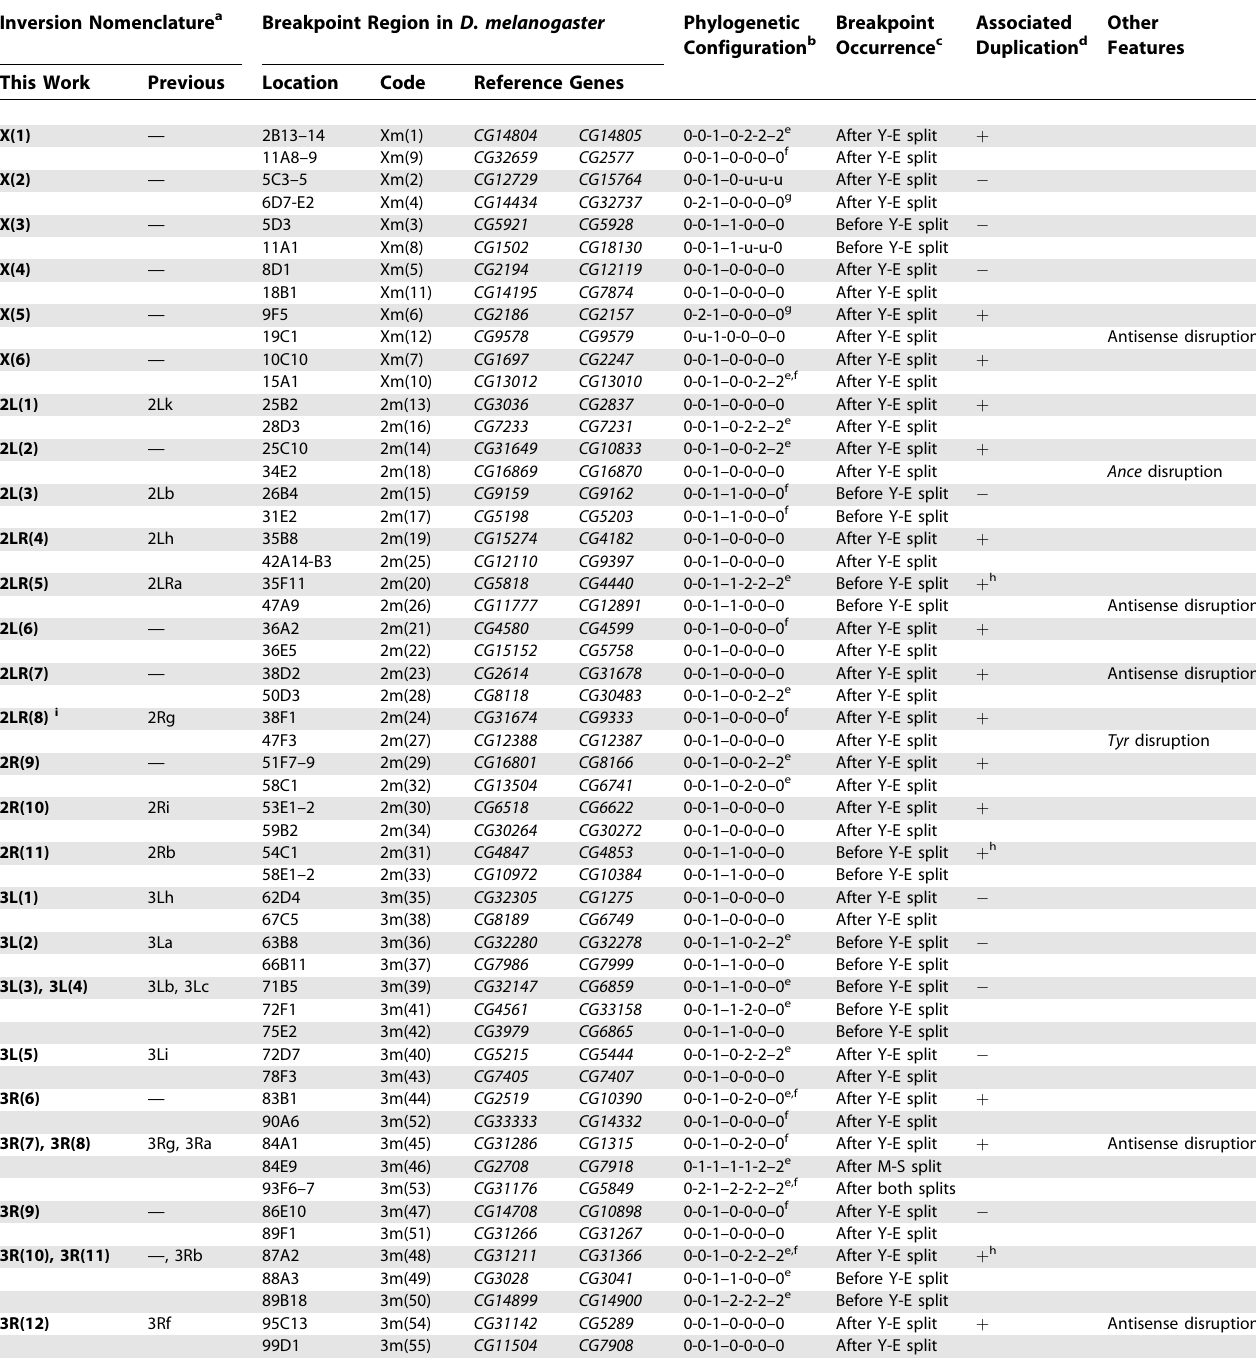
Table 1. Co-Dependent Breakpoint Regions in D. melanogaster versus D. yakuba and Inferences on the Phylogenetic Occurrences of